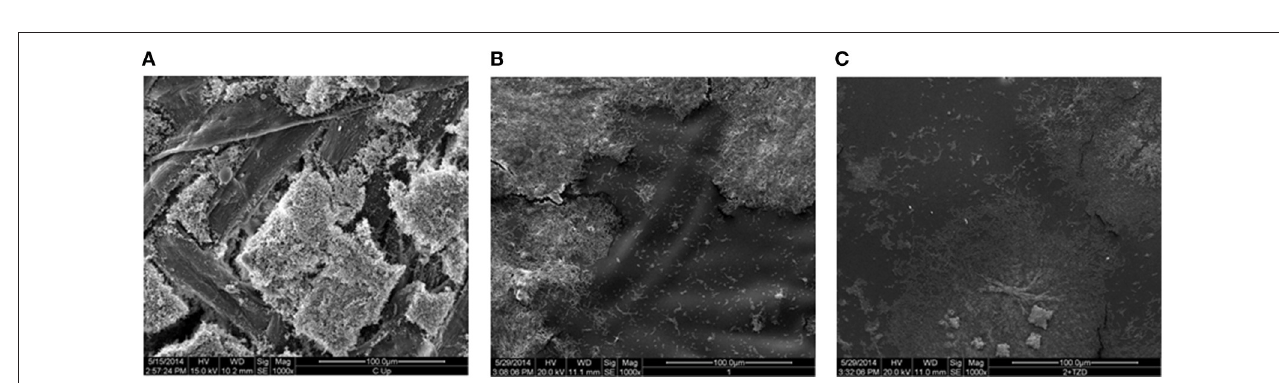
FIGURE 4 | qPCR quantification of 16s DNA of lysed P. carotovorum biofilms grown on corrugated cardboard discs. Application of bare polymer on corrugated cardboard surfaces leads to a 67.5% reduction in biofilm. Incorporation of TZDC-6 into the polymer results in an additional 14.3% reduction when compared to uncoated surfaces, and 43.9% when compared to bare polymer covered surfaces. * P < 0.05 .